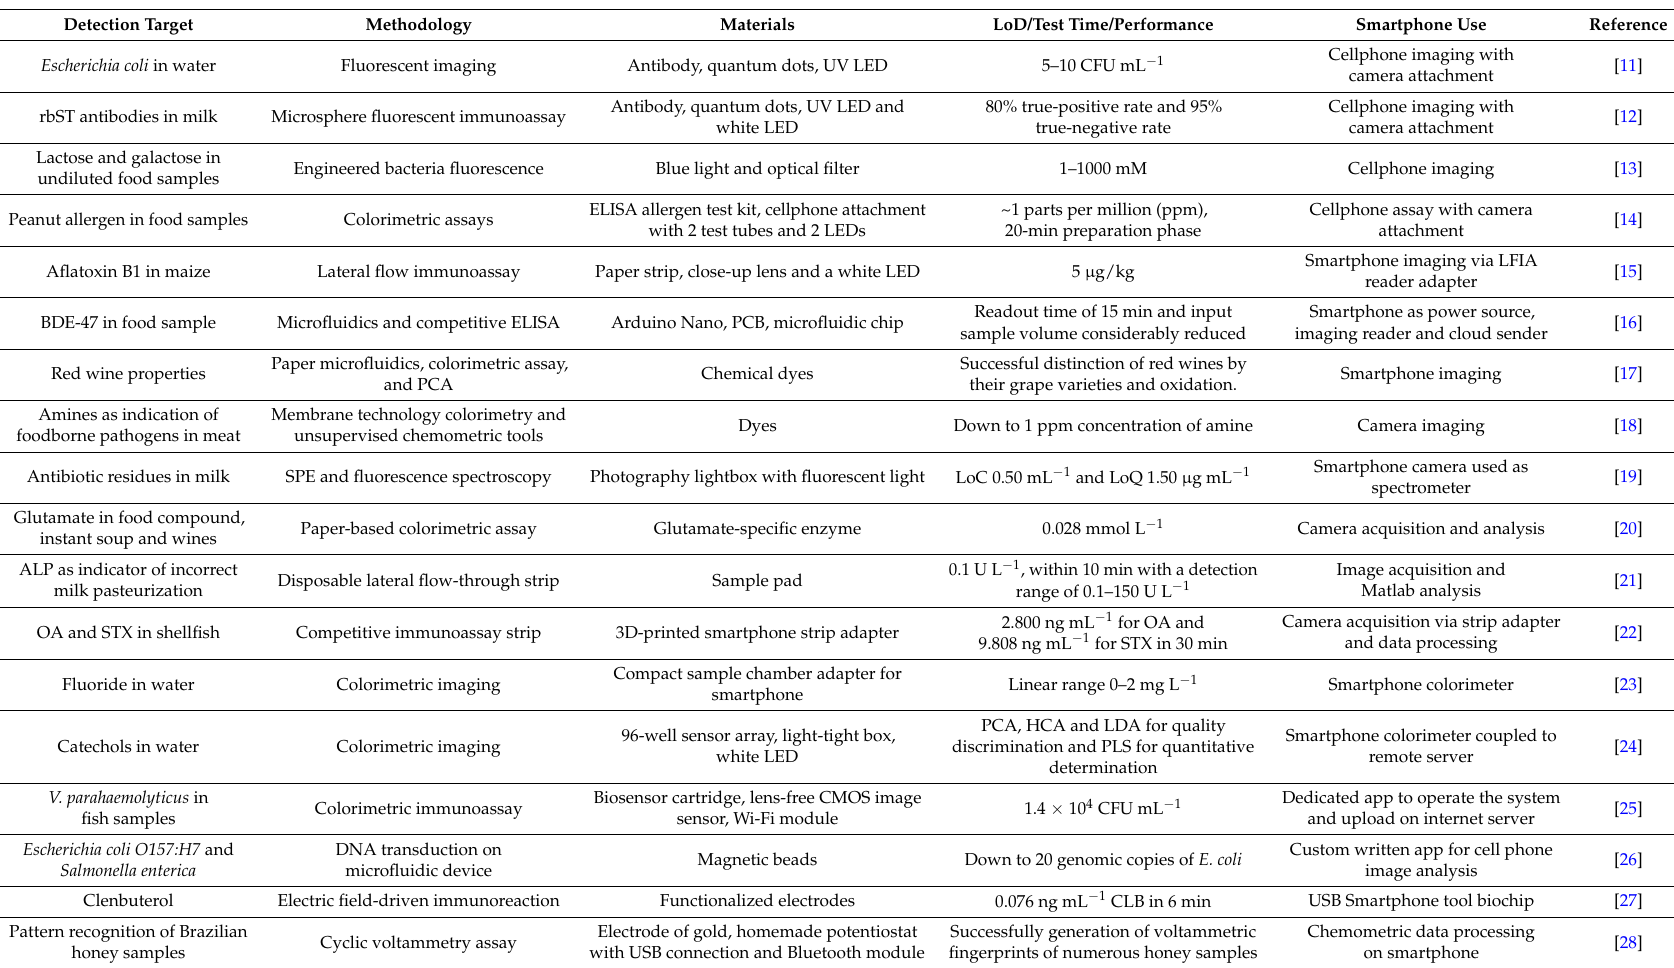
Table 1. Summary of recent lab-on-smartphone biosensor